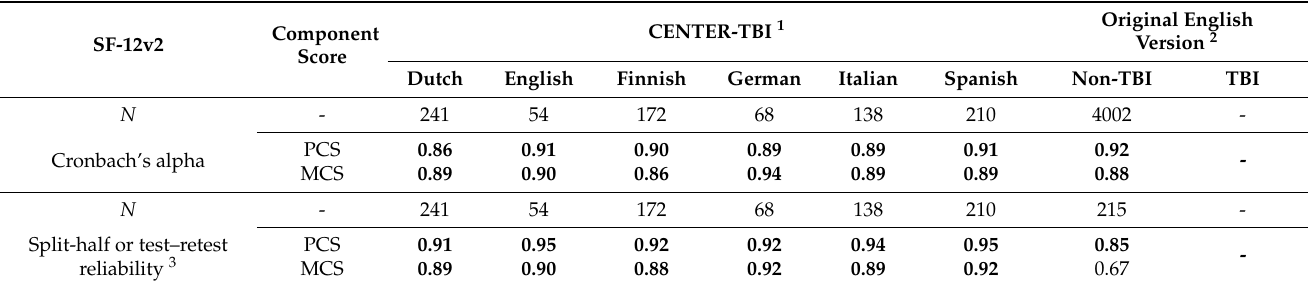
Table 8. Reliability of the SF-12v2: Comparison of the CENTER-TBI results with the values from the original English validation